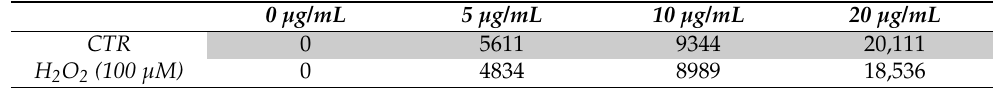
Table 1. Total polyphenol content in cultured